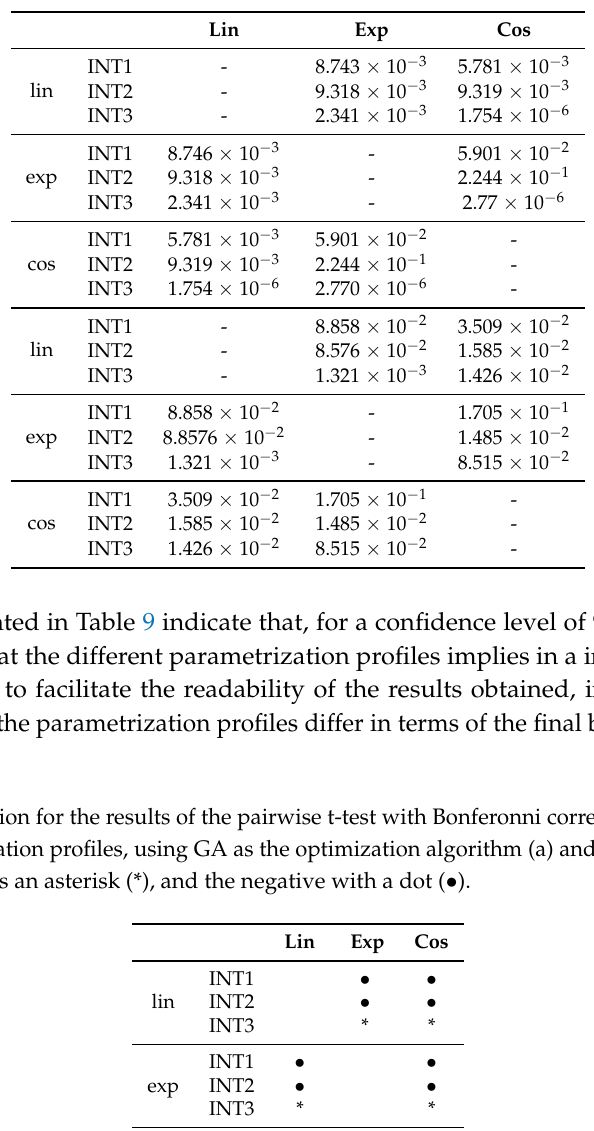
Table 9. Results of p -values for the pairwise t-test with Bonferonni correction, in terms of the different parametrization profiles, using GA as the optimization algorithm (a) and DE (b).